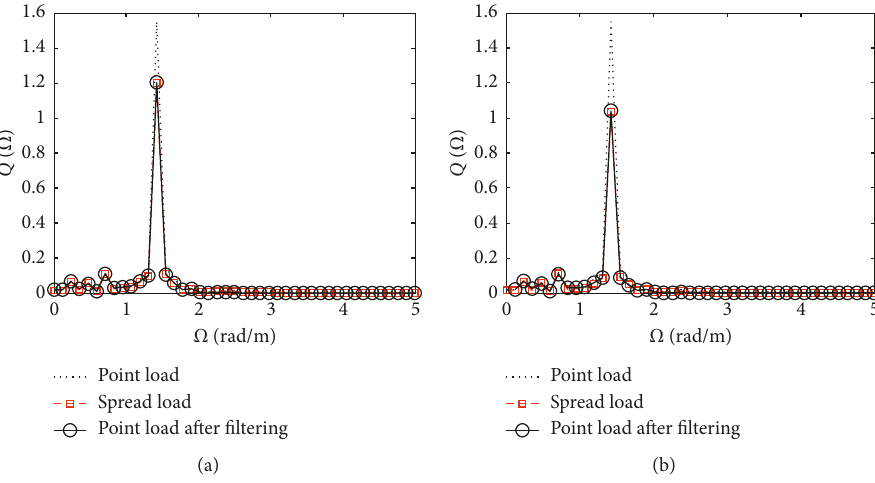
Figure 7: Bridge acceleration spectrum at resonance speed (ML model). (a) EC block load. (b) Triangular load.